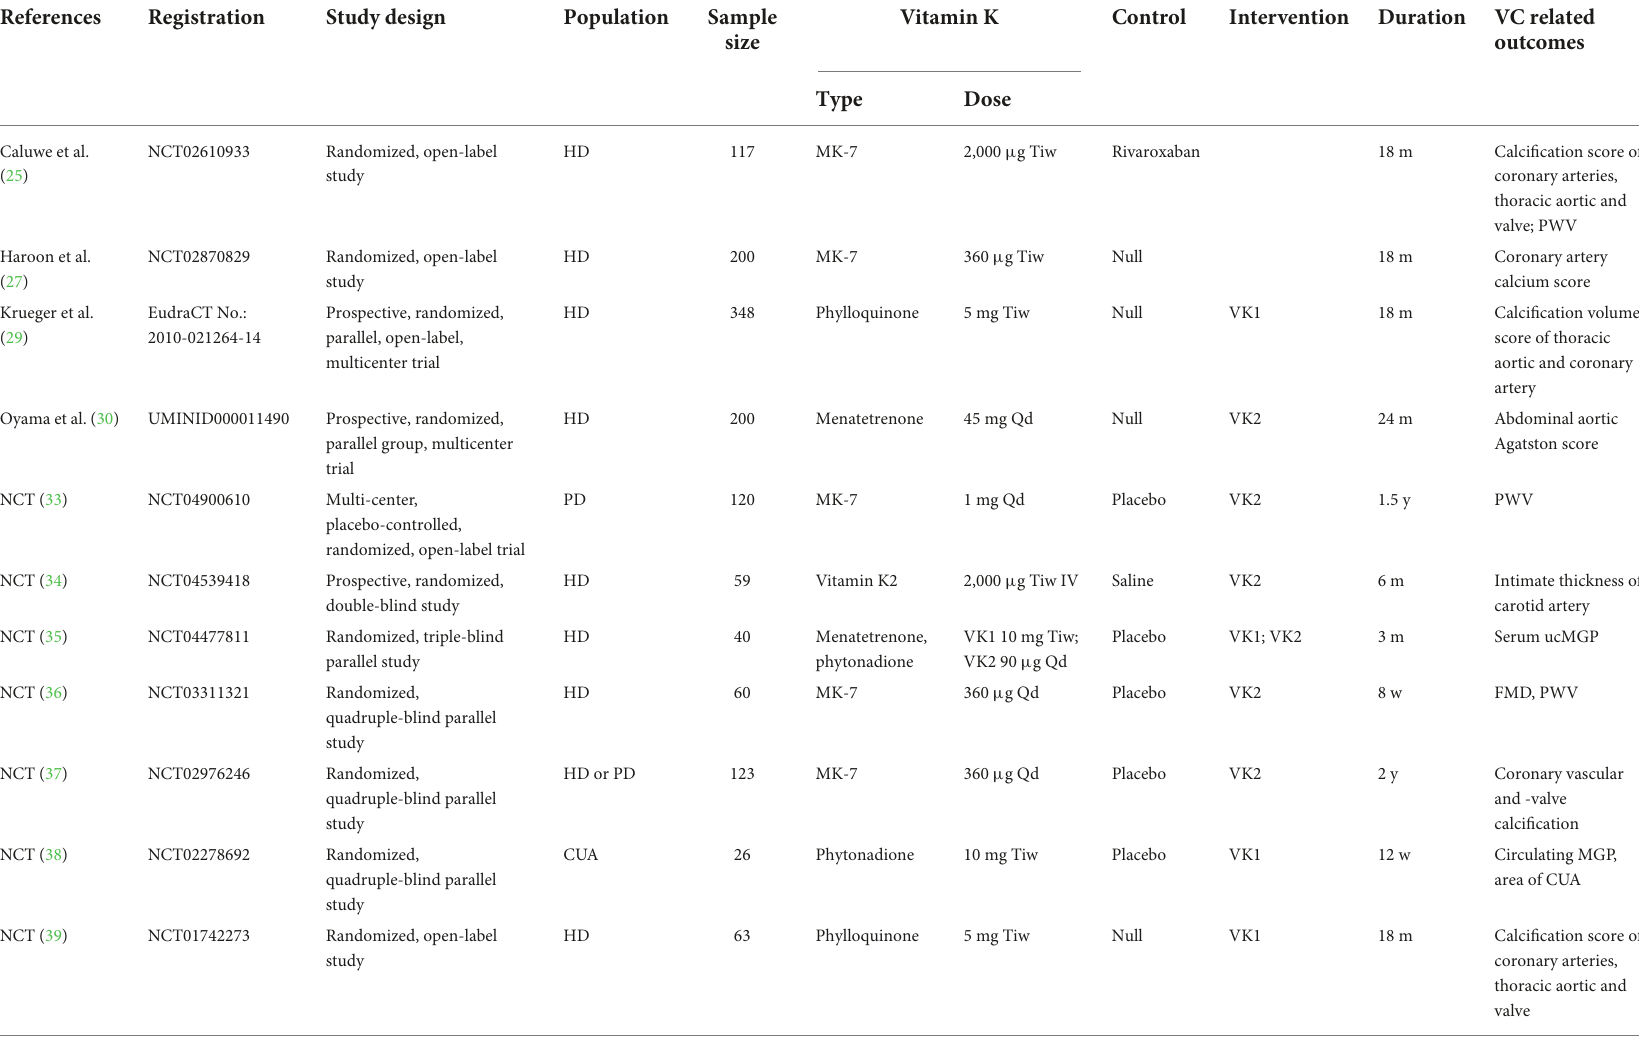
TABLE 2 A summary of ongoing clinical trials on the effect of Vitamin K supplementation to delay or even stop vascular calcification in CKD